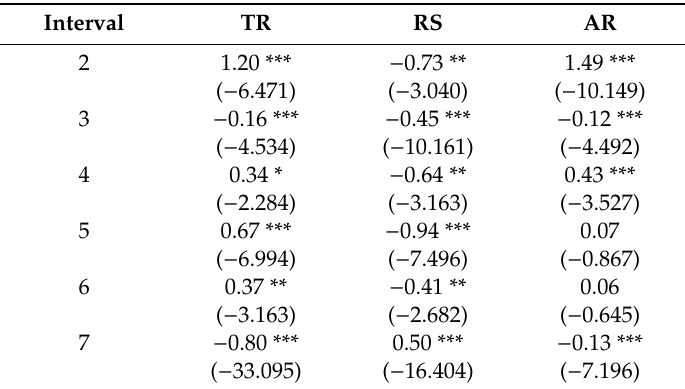
Table 1. Liquidity Measurements (%) and Abnormal Returns